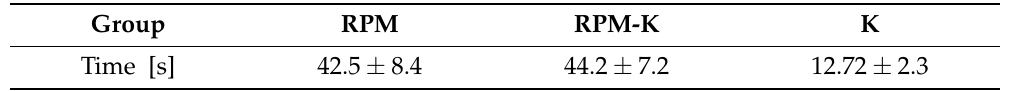
Table 4. Results from the social interaction experiment (time in seconds is presented by mean ±